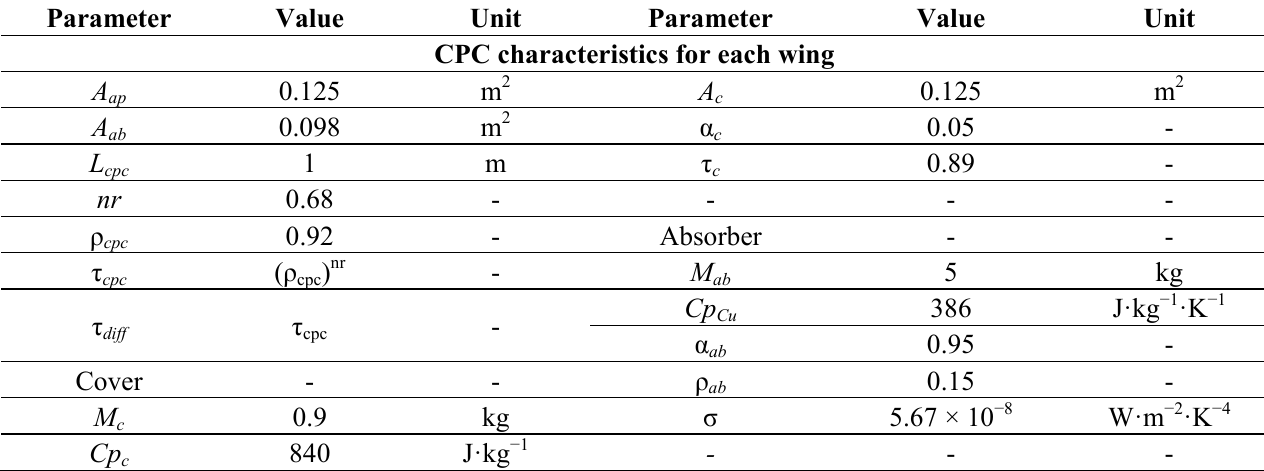
Table 1. Numeric values used in the